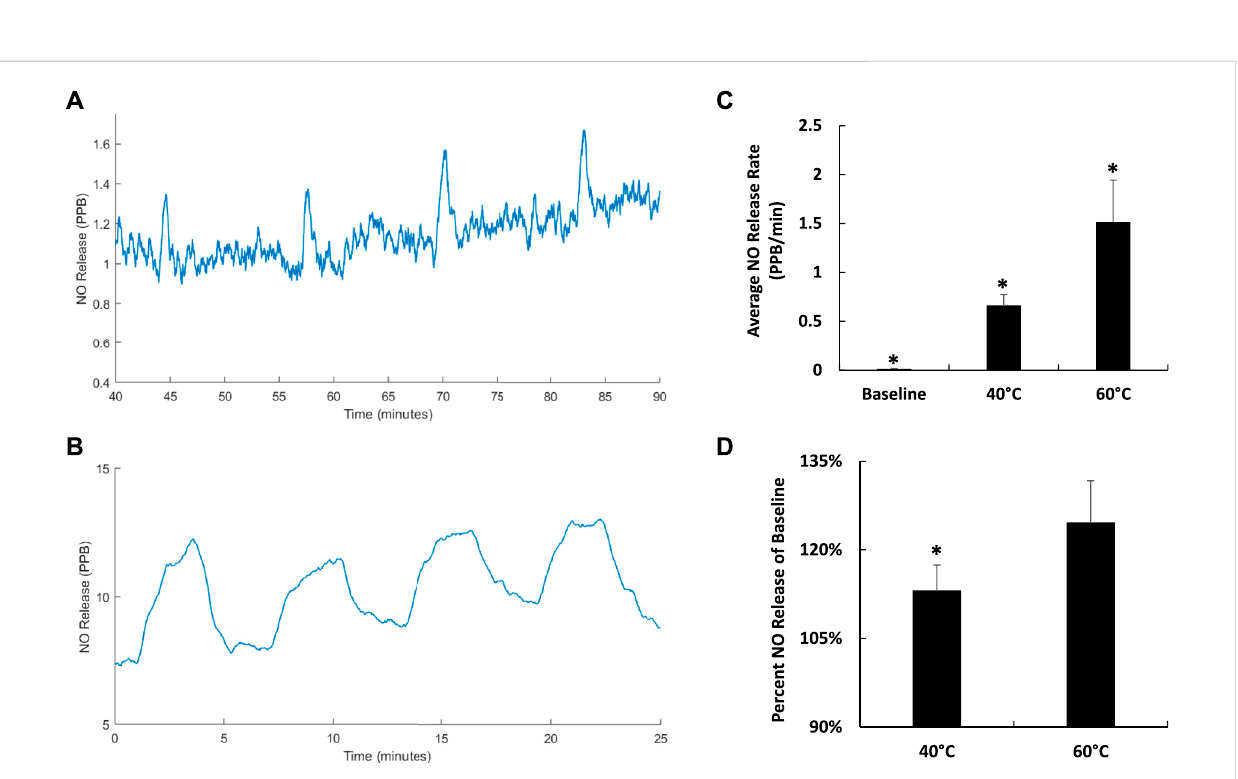
FIGURE 12 Instantaneous NO release from 4.8 mg SF hydrogels with cycles of 40 ° C (A) and 60 ° C (B) FUS heating treatments where hydrogel warming was achieved with a peak acoustic pressure of ±5.8 MPa. Average NO release rate with no FUS treatment and during hydrogel warming cycles to 40 ° C and 60 ° CwithFUS(n=4)(* p < 0.05) (C) .PercentNOreleaseduring hydrogelwarming cyclesto40 ° Cand60 ° CcomparedtobaselineNOrelease(n=4)(* p < 0.05) (D)